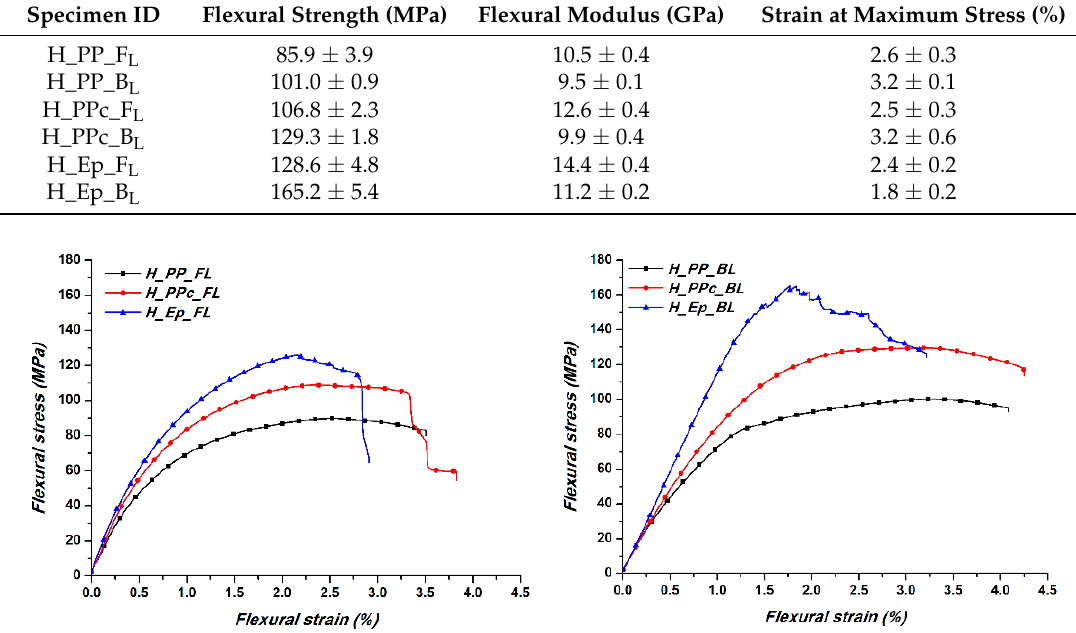
Figure 3. Typical stress vs. strain curves for flax/basalt composites along the warp (F L ) and weft (B L ) fiber directions. Table 2. Summary of flexural properties of flax/basalt hybrid laminates.